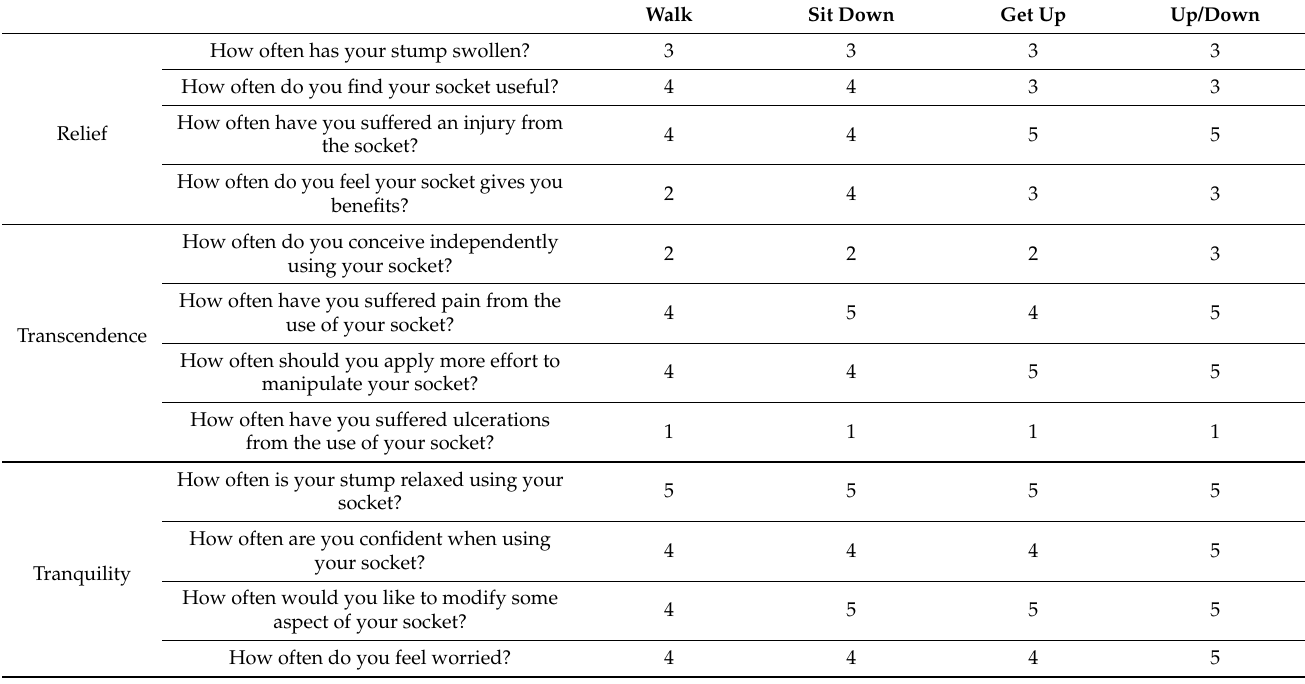
Table A4. Questionnaire applied to the